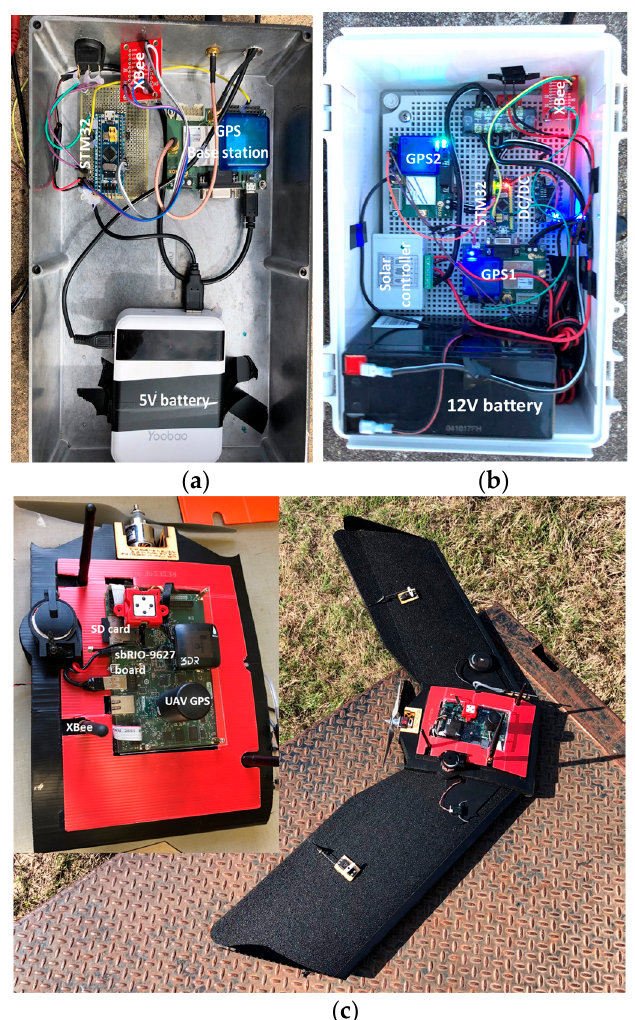
Figure 1. Overall schematic diagram of the wireless system network.